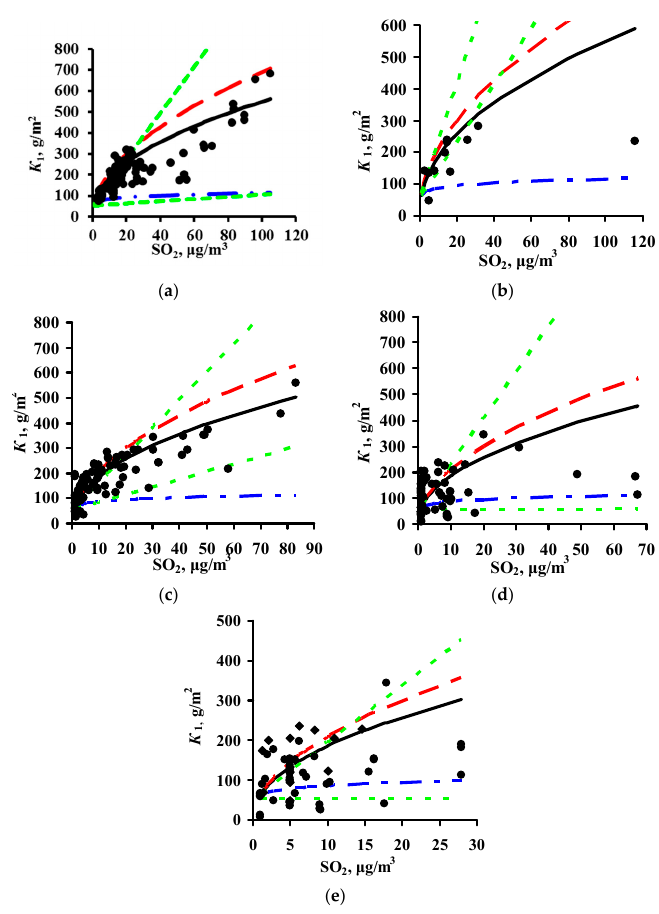
Figure 1. Dependence of first-year corrosion losses of steel ( K 1 ) on SO 2 concentration based on data from ISO CORRAG program ( а ), Ref. [19] ( b ), UN/ECE program ( c ), MICAT project ( d ), and data from MICAT project cited in [20] ( e ). ▬▬ — α = 0.47 (New DRF), ▬ ▬ — α = 0.52 (Standard DRF), ▬ ● ▬ — α = 0.13 (Unified DRF), (cid:150)(cid:150)(cid:150) —model [20] for TOW ranges in accordance with the data in Tables